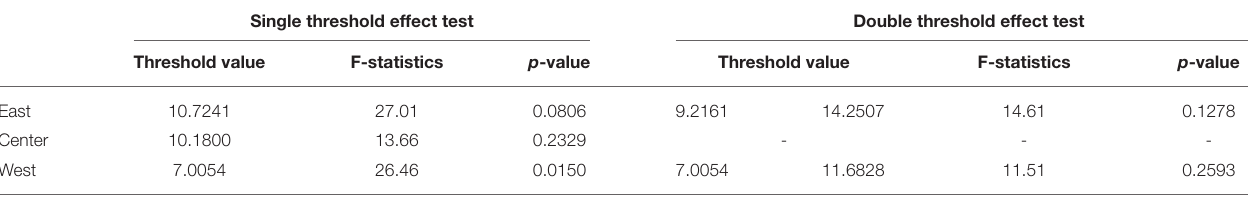
TABLE 3 | Threshold test between urbanization and health care expenditure.